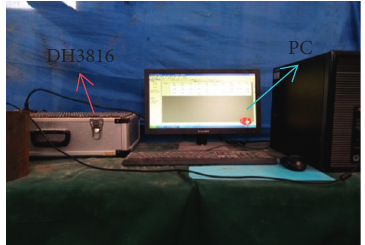
Figure 11: Drum damage.